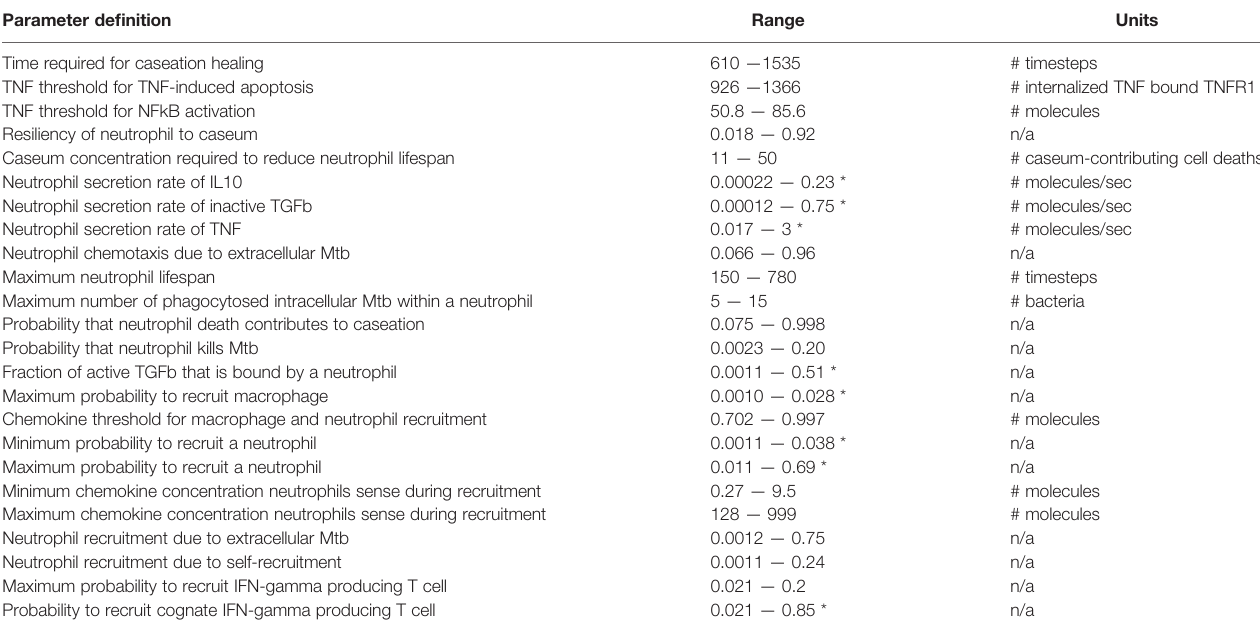
TABLE 1 | Parameters that were varied in the neutrophil-speci fi c parameter set. Parameter de fi